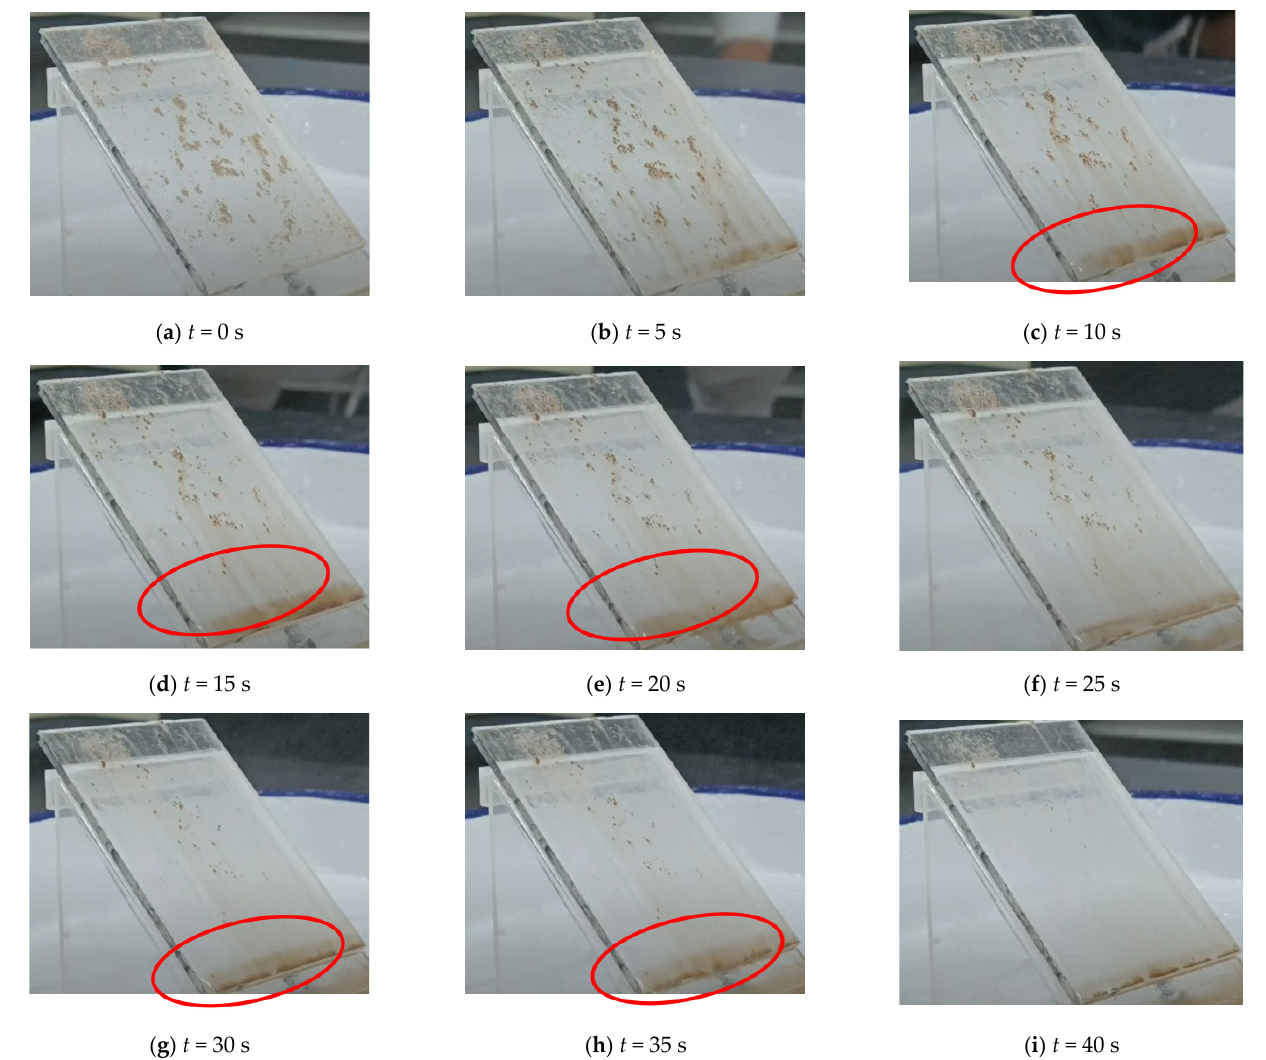
Figure 8. Dust cleaning process under water spraying for the super-hydrophilic coating. Figure 9. Dust cleaning process under water spraying for the super-hydrophilic